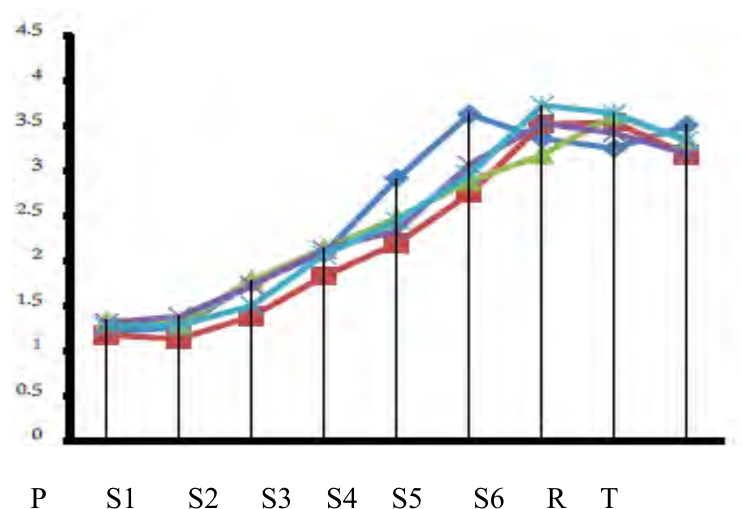
Fig 1. Students' Mean Backhand Accuracy in Pretest Session (P), Exercise Sessions (S1-S6) & Retention-Transfer Session (R &T)